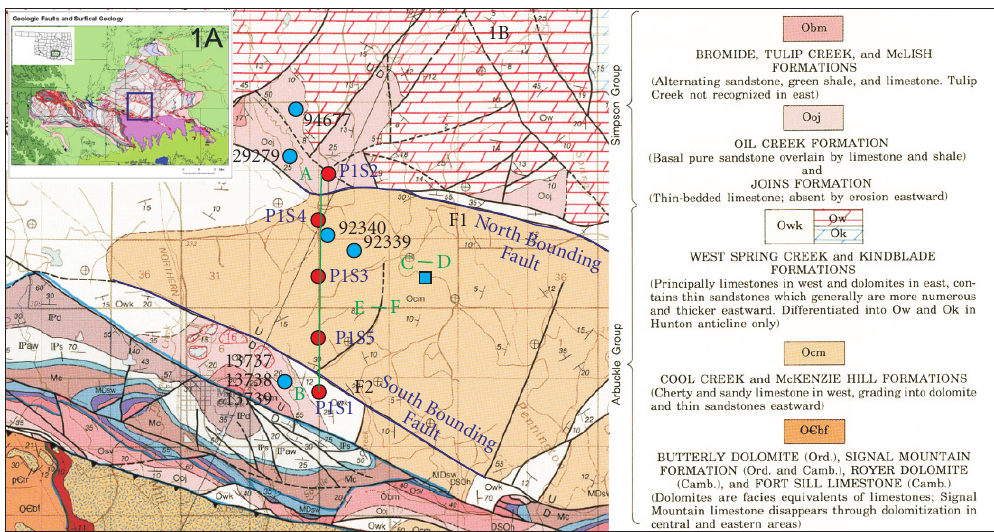
Figure 1: (a) Geographic location of the study area in Oklahoma. (b) Fault structure map of the Mill Creek block, Arbuckle-Simpson aquifer (From [13]). Line A-B represents the N-S sounding profile. CD and EF represent the electrical resistivity tomography profile locations. Red dots indicate the locations where electrical resistivity sounding data were collected. Faults F1 and F2 are imaged in the subsurface using electrical resistivity method to understand how they control ground water flow in the region. Well locations from which depth to groundwater level were obtained are shown by blue dots along with well numbers. Blue square indicates the location of Pilot